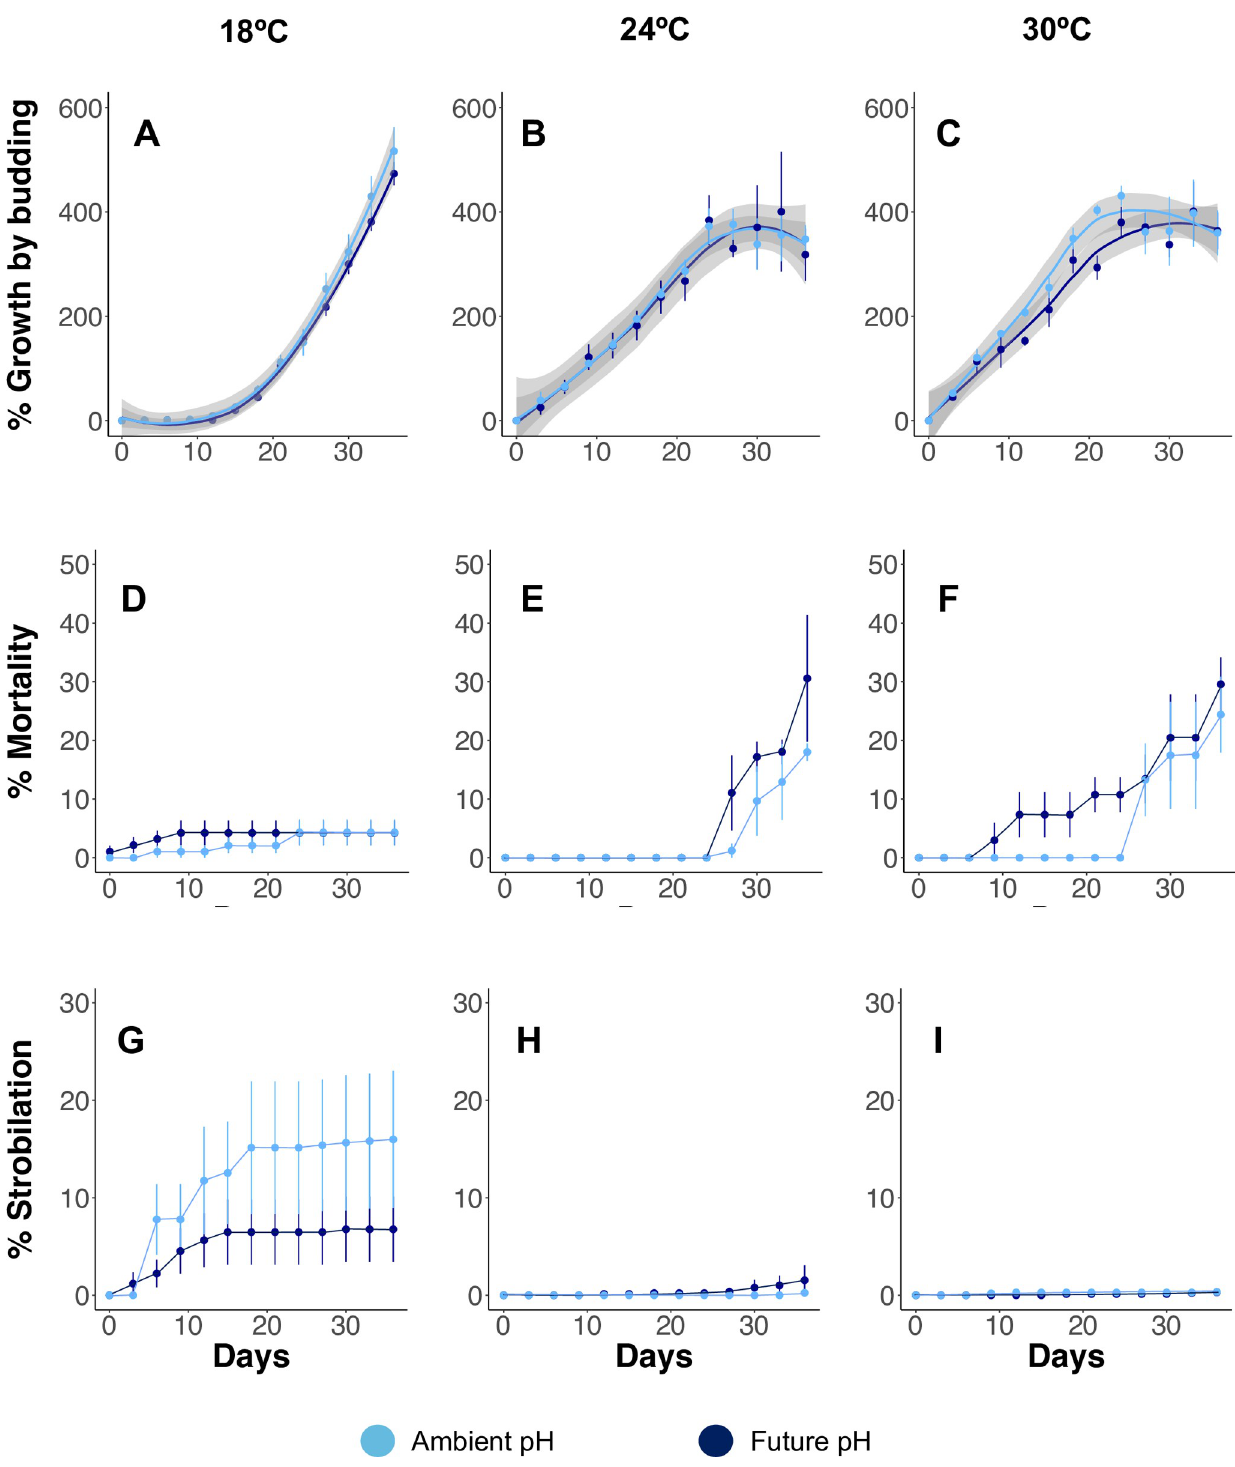
Fig 3. Population growth by budding, mortality and, strobilation of Cotylorhiza tuberculata polyps under tested temperatures (18, 24 and 30˚C) and pH levels (ambient and future). A, B, C. Percentage of growth of polyps by asexual reproduction (budding). D, E, F. Accumulate percentage of polyp mortality. G, H, I. Accumulate percentage of strobilation. Light blue for ambient pH conditions ( P CO2 ~ 500 ppm) and dark blue for future pH conditions ( P CO2 ~ 1000 ppm). Error bars are standard deviation. Grey bands are standard